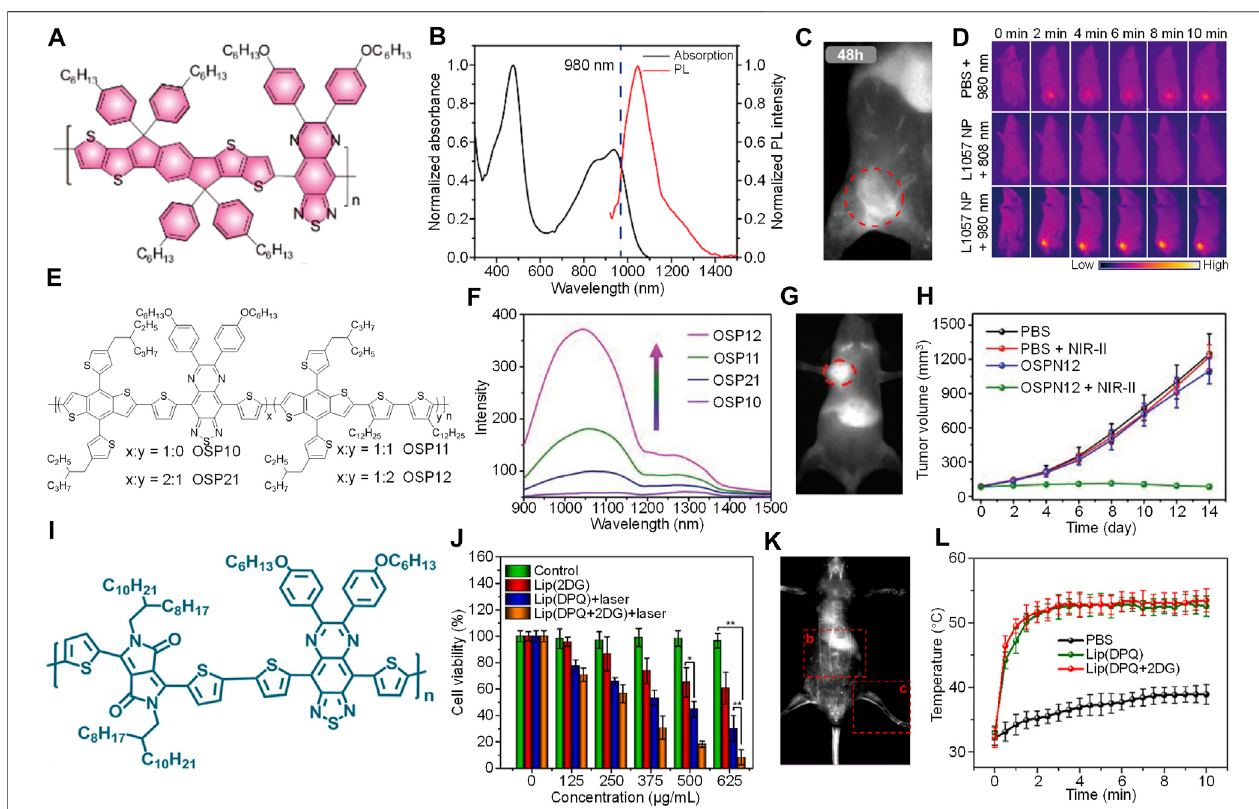
FIGURE1|(A) Chemicalstructure ofPTQ. (B) Absorptionandemission spectraofL1057NPs. (C) NIR-II fl uorescence imagingoftumorbearingmice treatedwith L1057 NPs at t (cid:1) 48 h post-injection. The red circle indicates the location of the tumor. (D) Photothermal images of tumor bearing mice under different treatments.